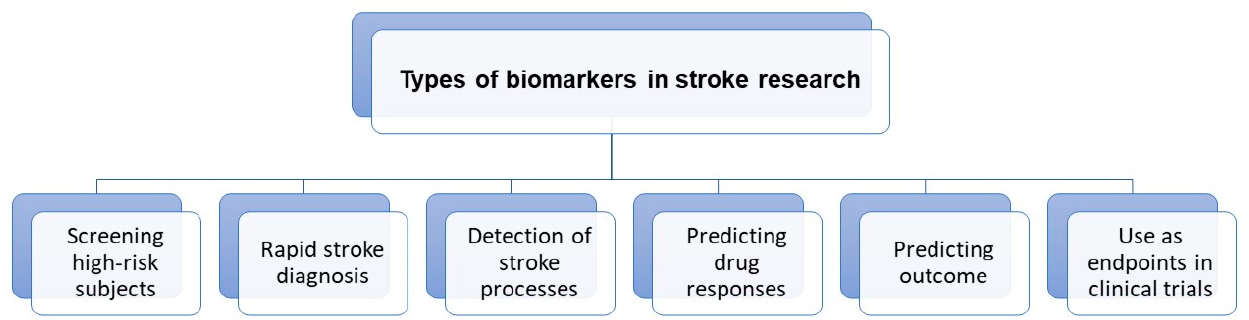
Figure 1. Roles of stroke biomarkers.